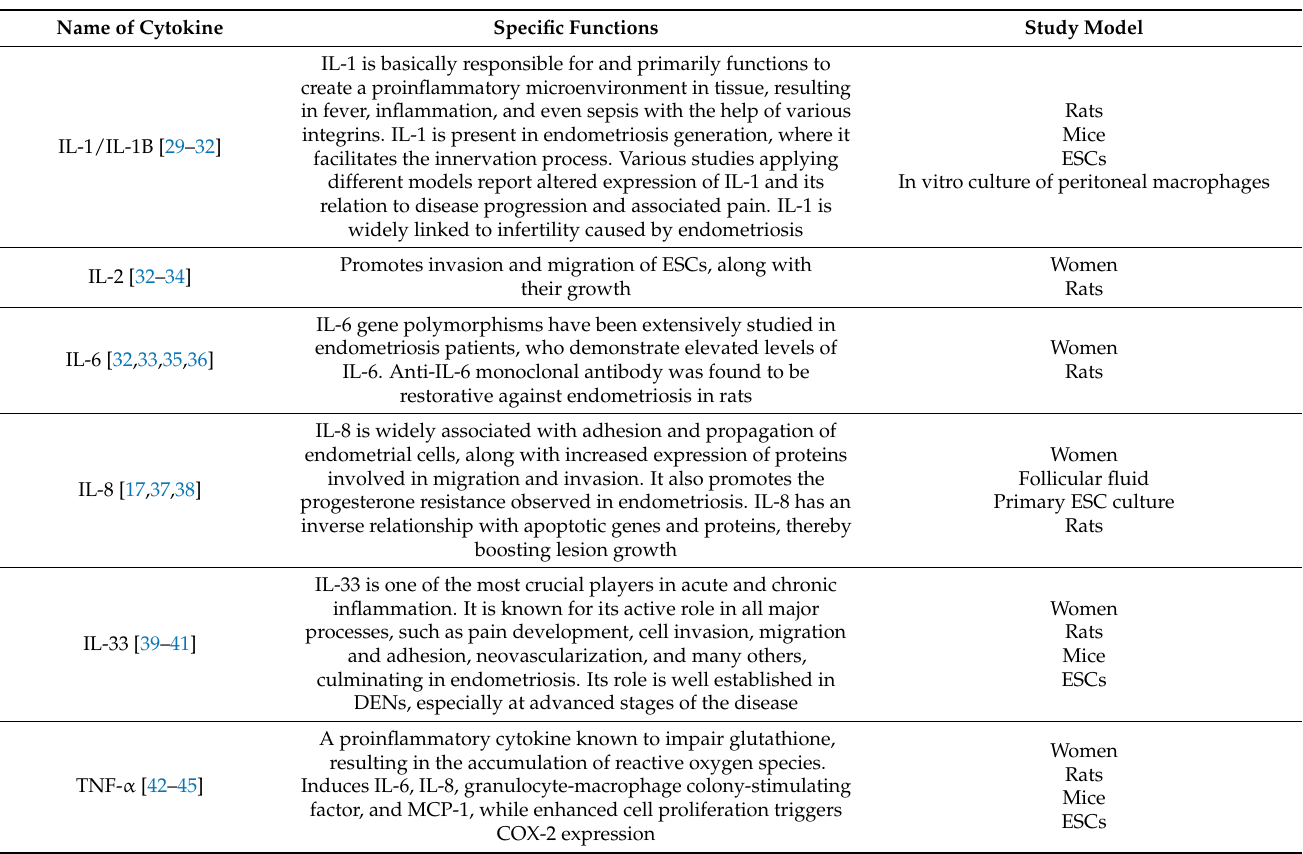
Table 3. Various cytokines and their role in the activation and development of endometriosis. Name of